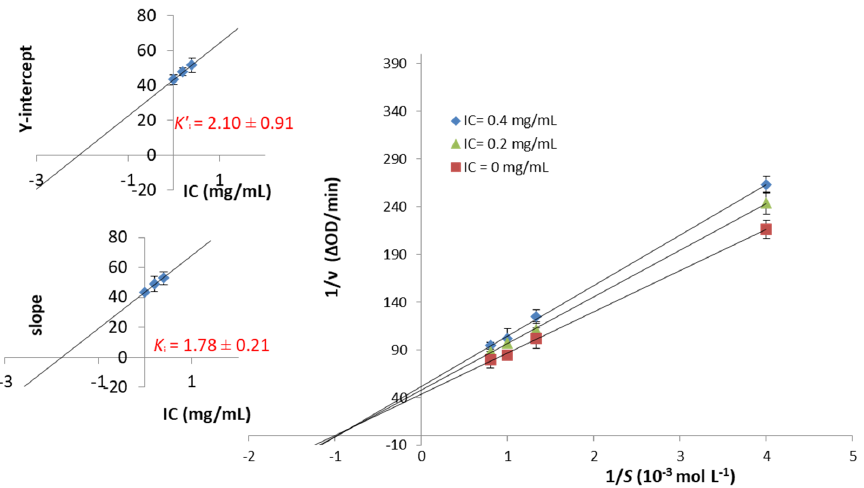
Figure 2. Lineweaver-Burk (L-B) of α -Amylase in the presence of inulin from topinambur (IT). The inset depicts the Cornish-Dowden plot to determine the K’ i constant.